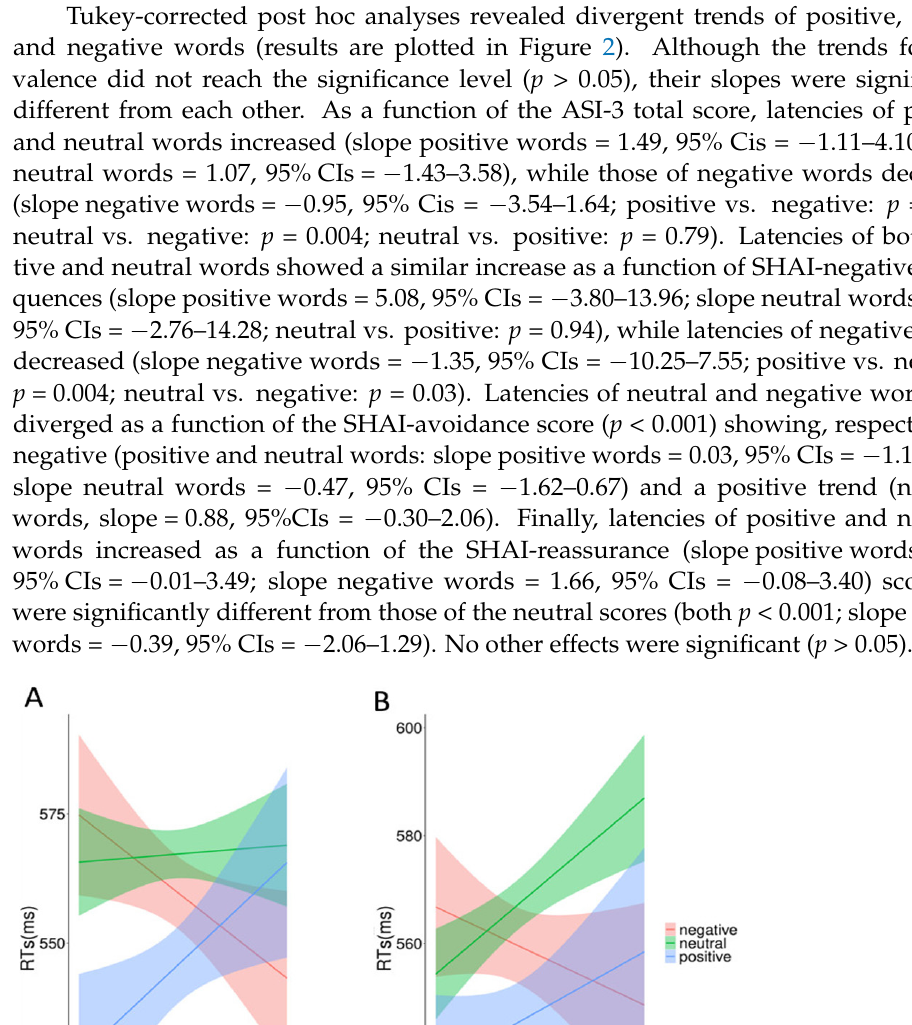
Figure 2. RTs for positive, negative and neutral words as function of the scores at ASI-3 ( A ), SHAI -negative consequences ( B ), SHAI-avoidance ( C ) and SHAI-reassurance ( D ). 3.2. Omission Errors In the first model with valence as a fixed factor, the results did not show a significant main effect (F 2 = 0.04, p = 0.5). In the second model adding ASI-3 total and SHAI subscales as fixed factors, the results confirmed the results of valence (F 2 = 0.04, p = 0.5). Importantly, the results showed significant interactions between valence and both the ASI-3 total score (F 3 = 4.17, p = 0.003) and SHAI-avoidance (F 3 = 3.12, p = 0.02). The results for the two models are summarized in Table 3 . Table 3. M1 investigates the main effect of valence (positive vs. neutral vs. negative) on omission errors. M2 tests the interaction between valence and ASI and SHAI’s subscales scores. Model